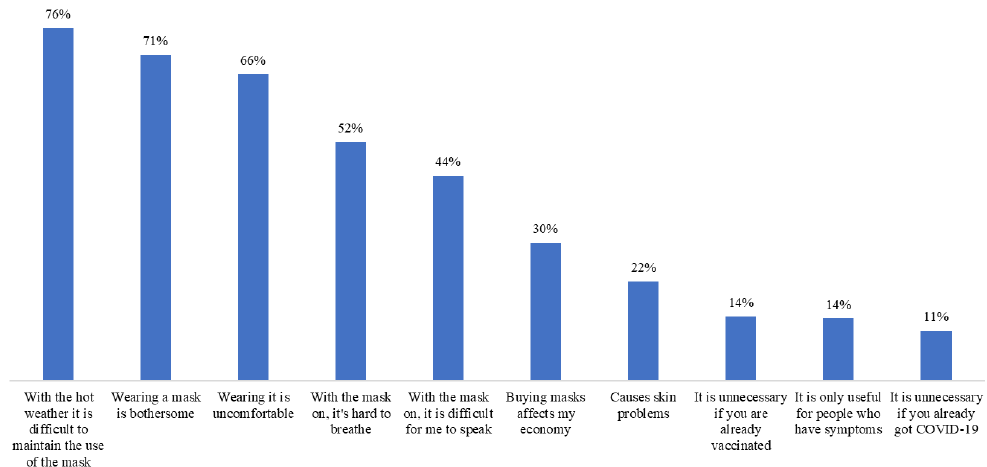
Figure 4. Perception of barriers to wearing face masks in patients with diabetes (n = 288).